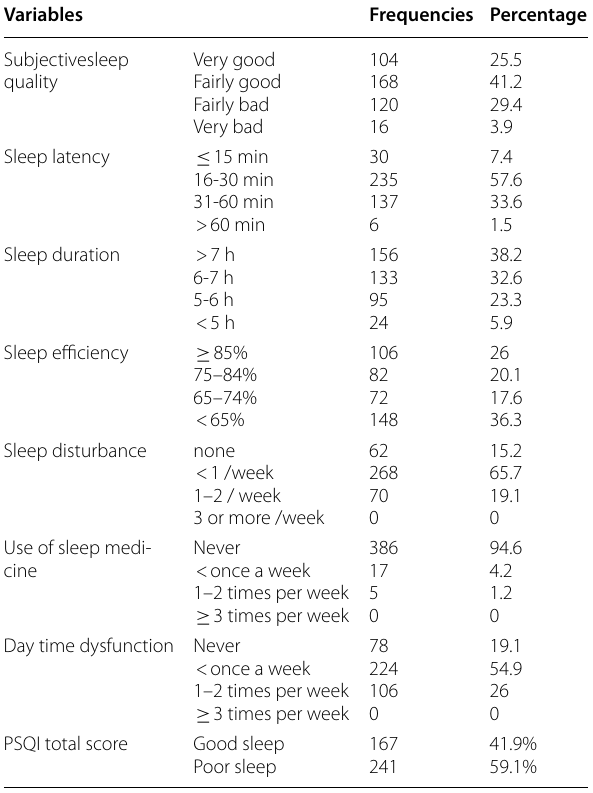
Table 4 Sleep quality and its component scores